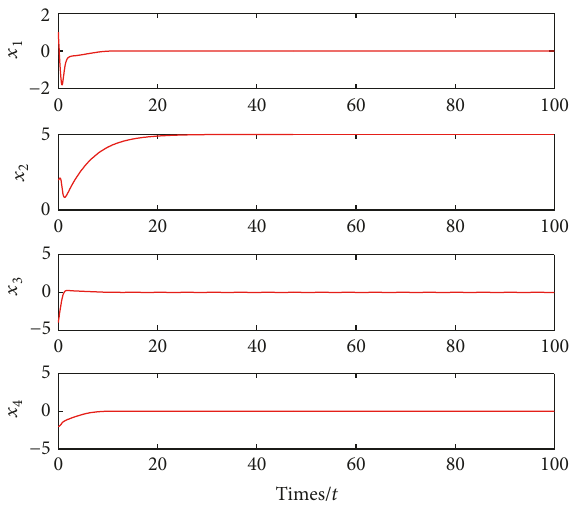
Figure 7: The figure shows that the orbit 𝑋(𝑡) of the system (14) converges to (0,5,0,0) 𝑇 as 𝑡 → ∞ .